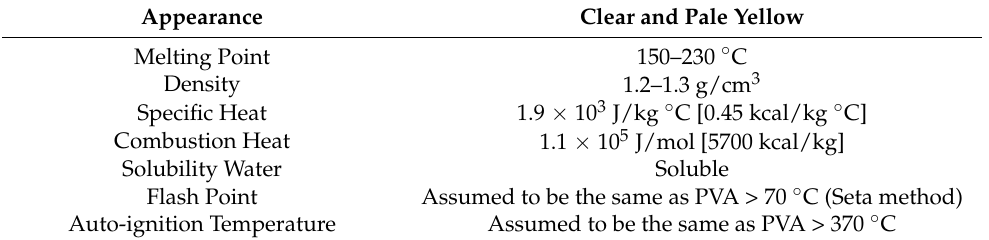
Table 2. Physical and chemical properties of PVA film. Appearance Clear and Pale